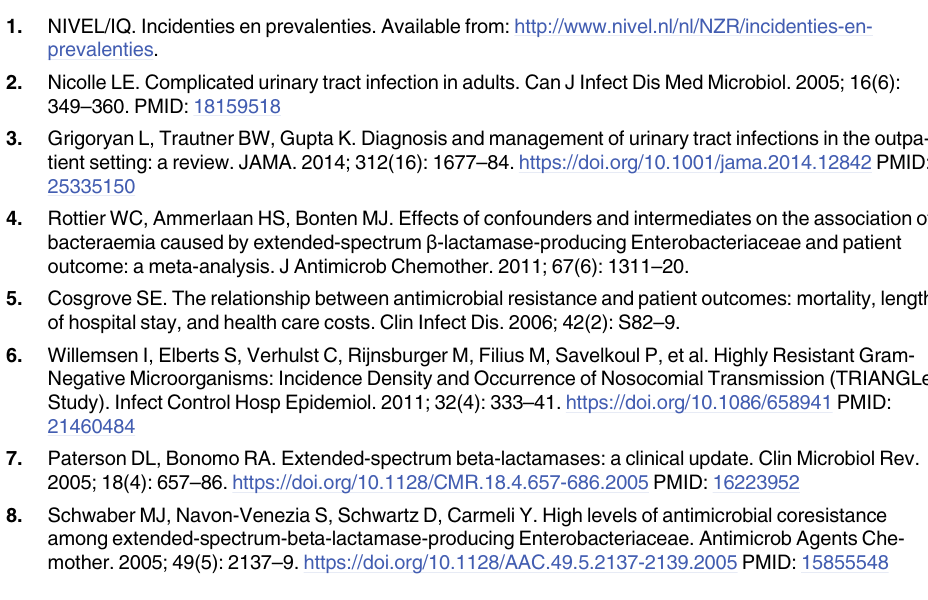
S1 File. Table A, Table B, Table C and Table